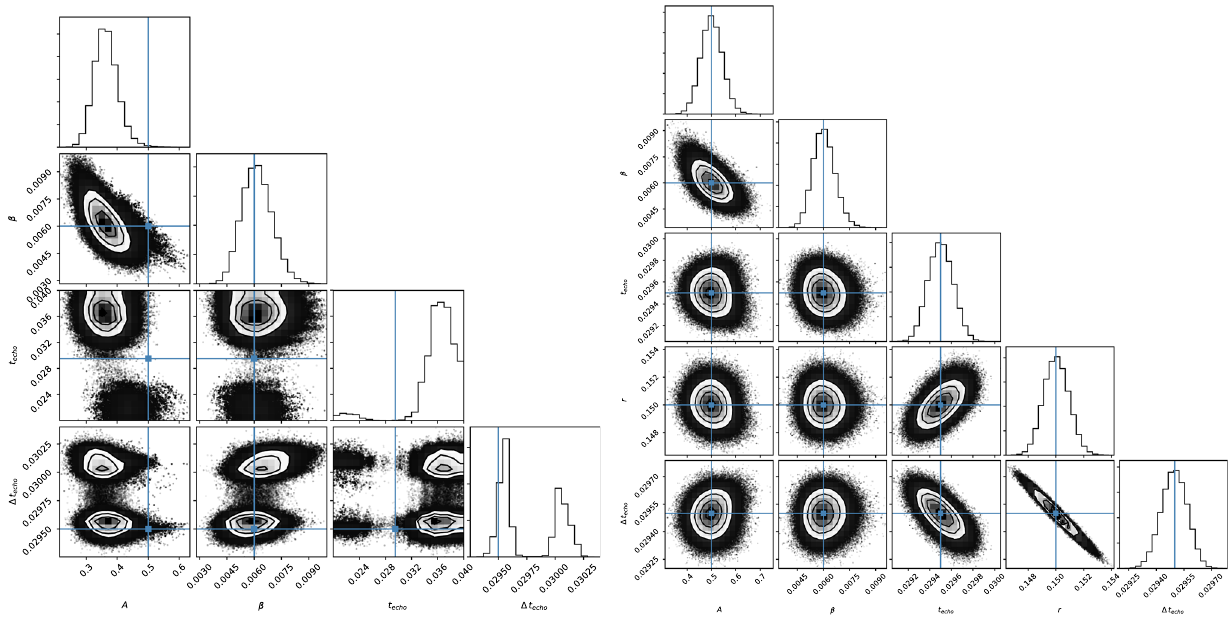
Fig. 2 Cornerplots(leftpanelfortheCIEmodelandrightpanelforthe UIE model) of the posterior samples from the parameter estimation on simulated data as describe in the main text. The blue solid lines denote the injected values for the respective parameters. Along the diagonal are the histograms of the estimated 1D marginal posterior probabil-